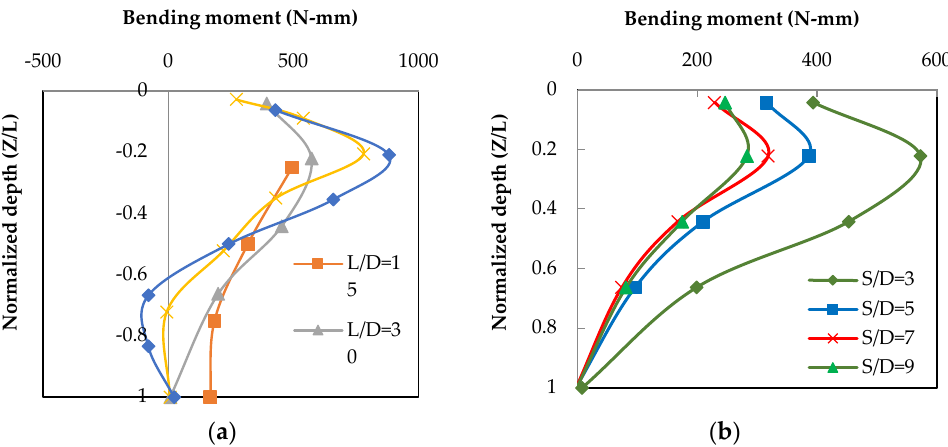
Figure 12. Bending moment profile: ( a ) effect of the slenderness of the pile for spacing S = 3 D , and ( b ) effect of spacing of the piles for a slenderness value of L = 30 D. Furthermore, the bending moment profile over the pile length for various pile spacings, ranging from 3 D to 9 D , for a pile slenderness value of 30 D , is plotted and is shown in Figure 12b. The highest value of the bending moment (573 N-mm) occurs at the piles modeled with a spacing of 3 D , compared to other spacing piles. The maximum values estimated for the piles with spacings of 5 D , 7 D , and 9 D are 386 N-mm, 318 N-mm, and 283 N-mm, respectively. It can be inferred from the bending moment profile plot for the scenarios of the various spacings that the piles experience higher values of bending moment as the spacing of the piles decreases. This is because of the group action of piles, which reduces the lateral resistance due to the degradation of soil stiffness. The reduction in